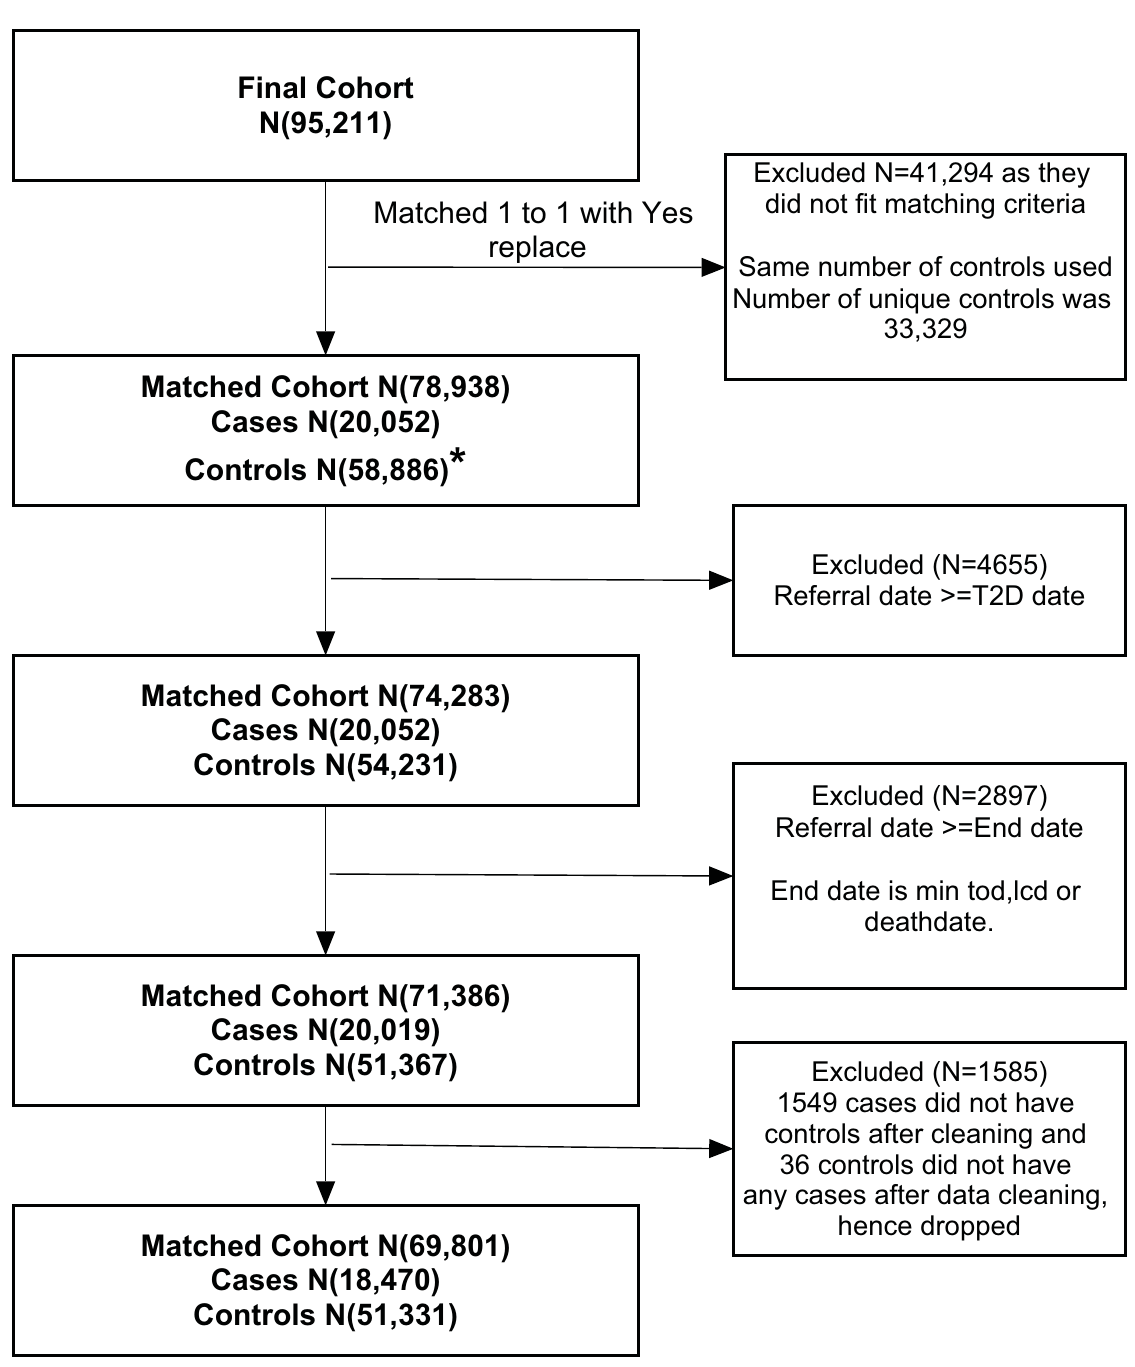
Fig 1. Flowchart on final matching numbers CPRD AURUM and GOLD. [Matching: Patients referred to the scheme versus matched patients not referred within the same practice, based on age (up to 3 years), sex, and within 365 days of NDH diagnosis: Cases- Referred to NDPP; Controls- Not Referred to